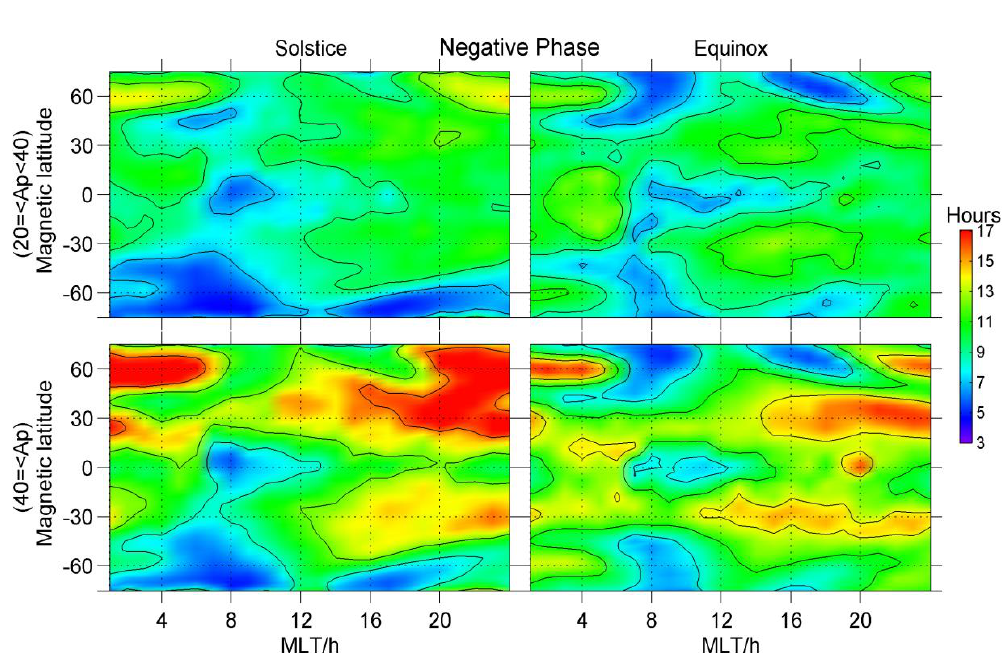
Fig. 3. Global distribution of the mean time delay related to negative ionospheric storms in the MLAT vs. MLT frame for solsticial months (left panels) and equinoctial months (right panels). The Northern Hemisphere of left panels locates in winter and the Southern Hemisphere corresponds to the summer months.